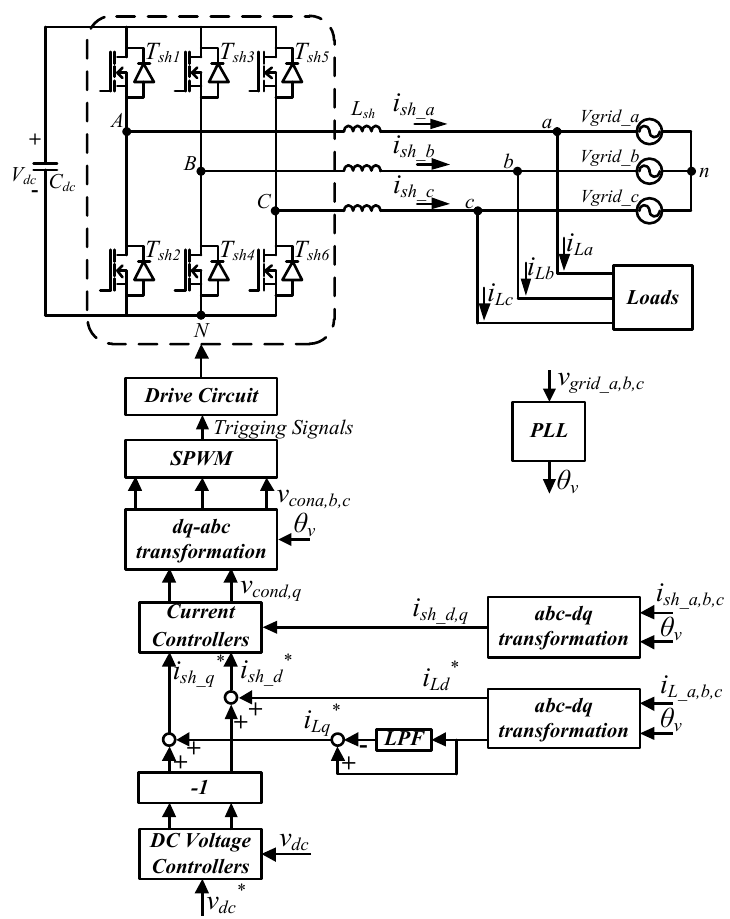
Figure 9. The circuit configuration of gallium nitride (GaN)-based shunt APF system and the block diagram of the control scheme.